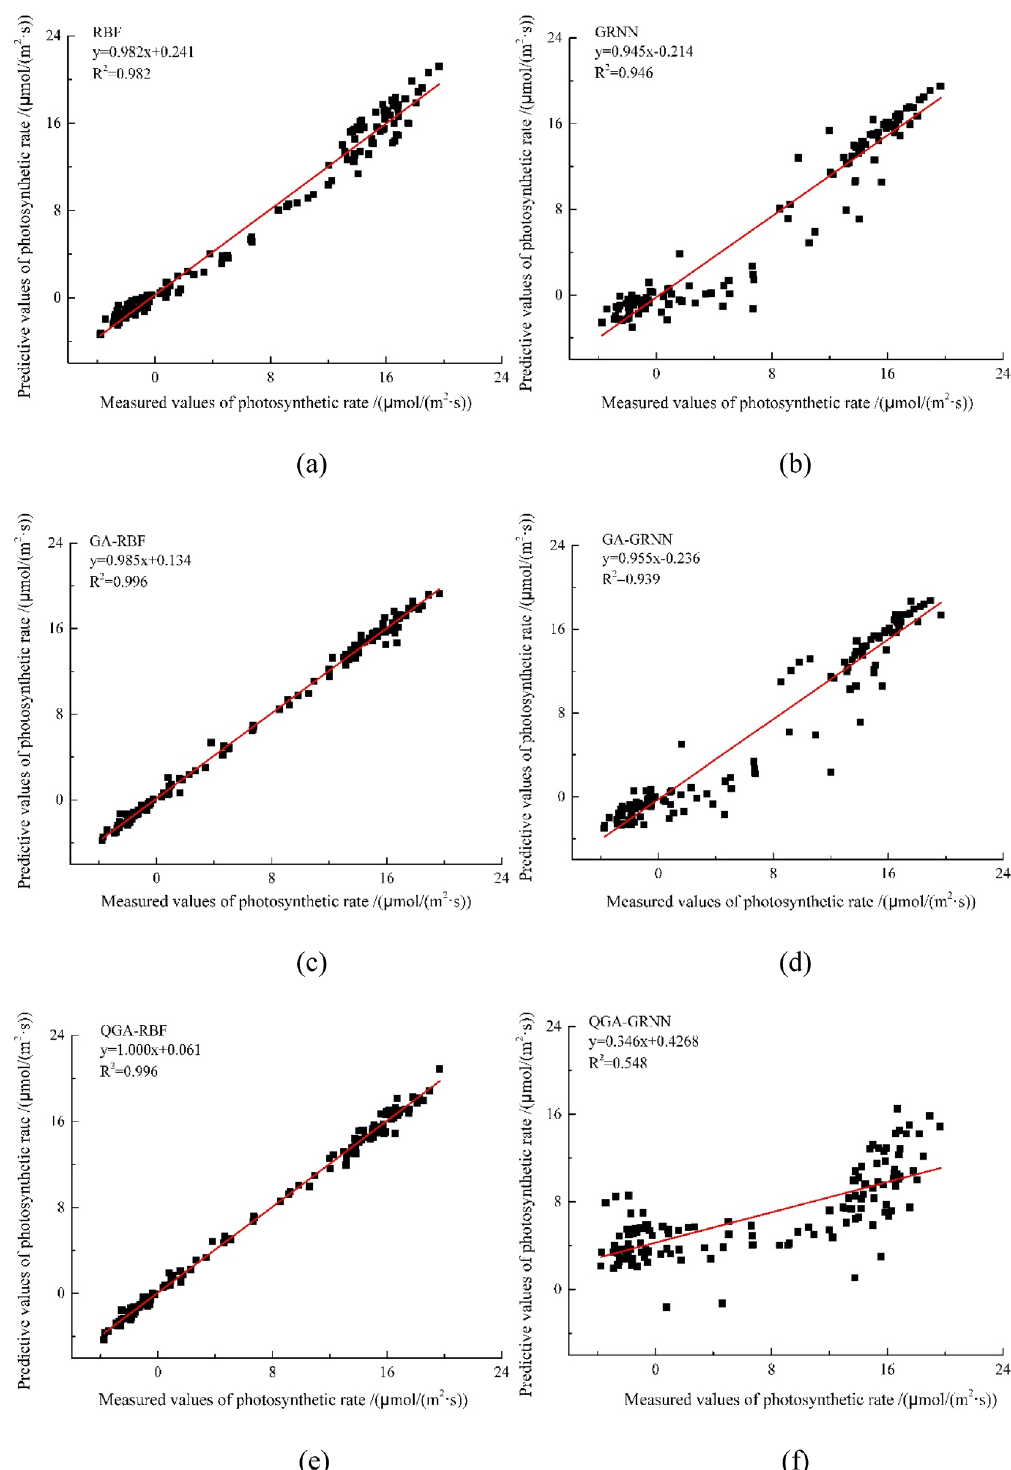
Figure 7. The performance of prediction model using different methods. ( a ) RBF ( b ) GRNN ( c ) QA-RBF ( d ) QA-GRNN ( e ) QGA-RBF ( f ) QGA-GRNN. The red line is a linear fitting to the